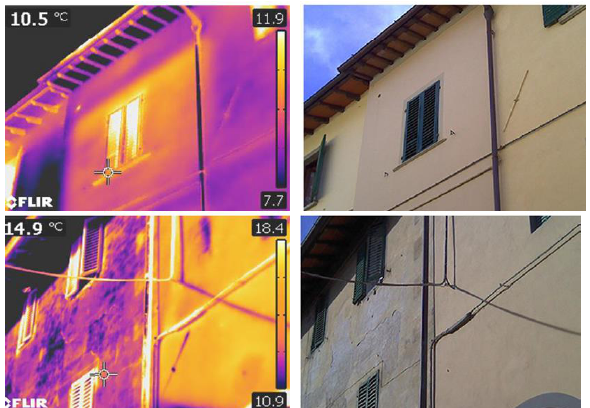
Figure 2. Thermography campaign; it has been made using a camera Flir